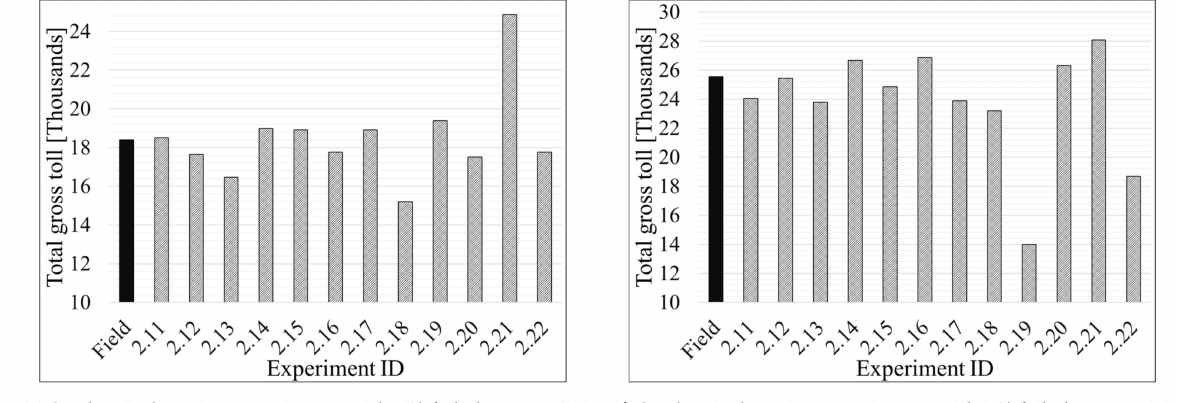
Figure 6. Graphical interpretation of total gross toll for systematic and stochastic failure and error scenarios on Southbound